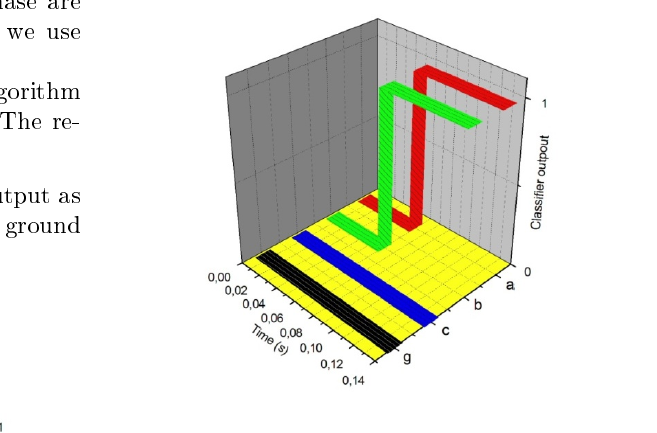
Fig. 7: Fault classi(cid:28)er output for the single-phase to ground fault in the phase "a".